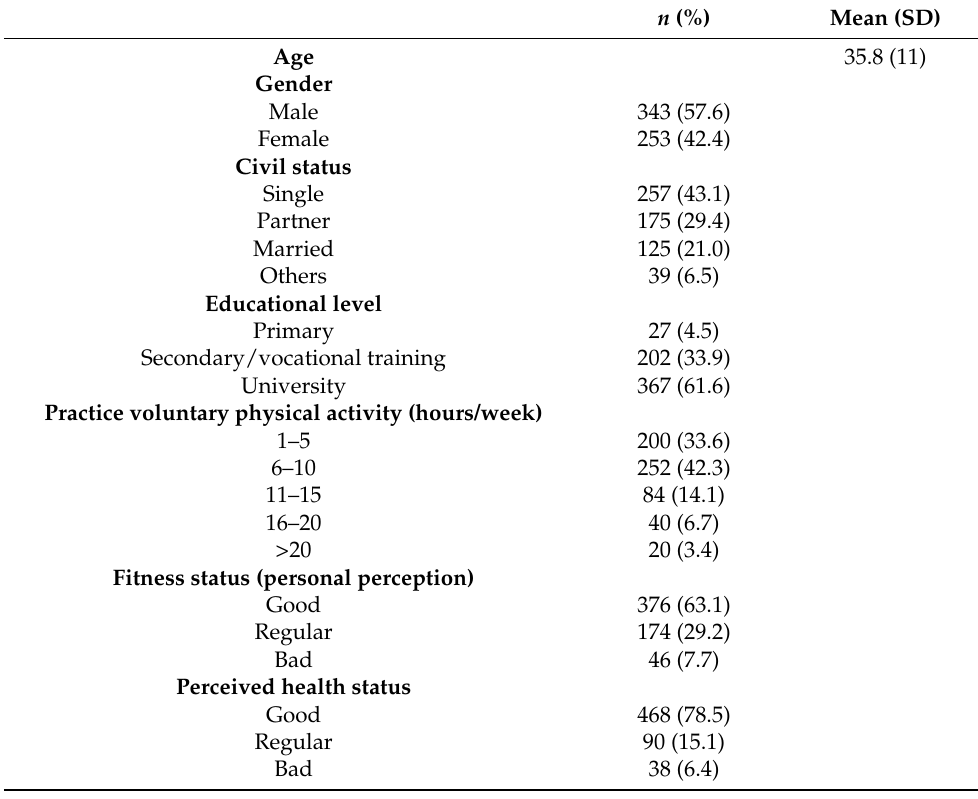
Table 1. Socio-demographic data of the